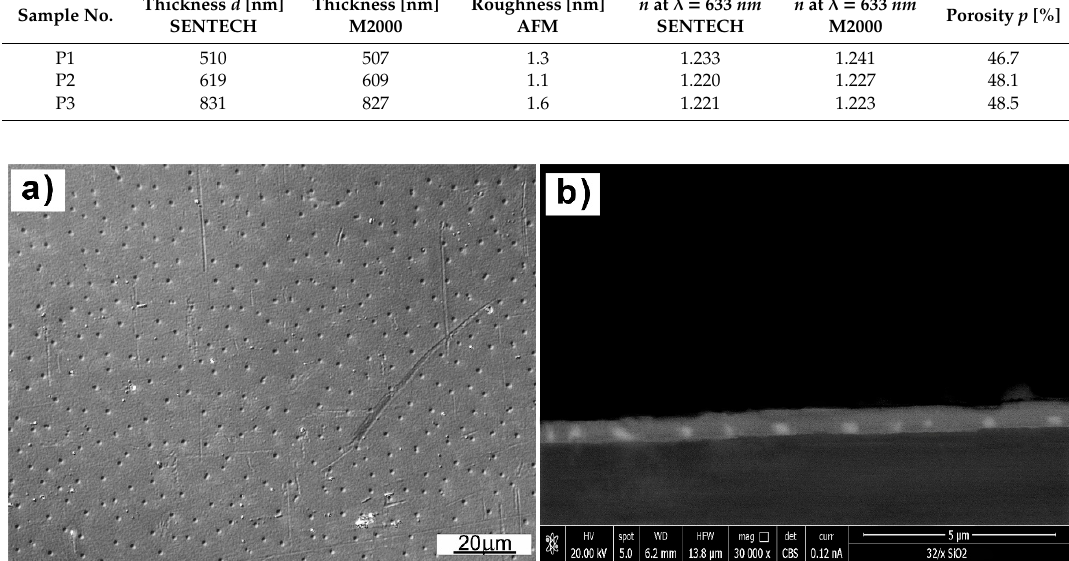
Figure 2. SEM micrographs of SiO 2 films: ( a ) Surface of porous silica film, ( b ) film profile of sol-gel-obtained porous SiO 2 film on Si substrate (sample P1).